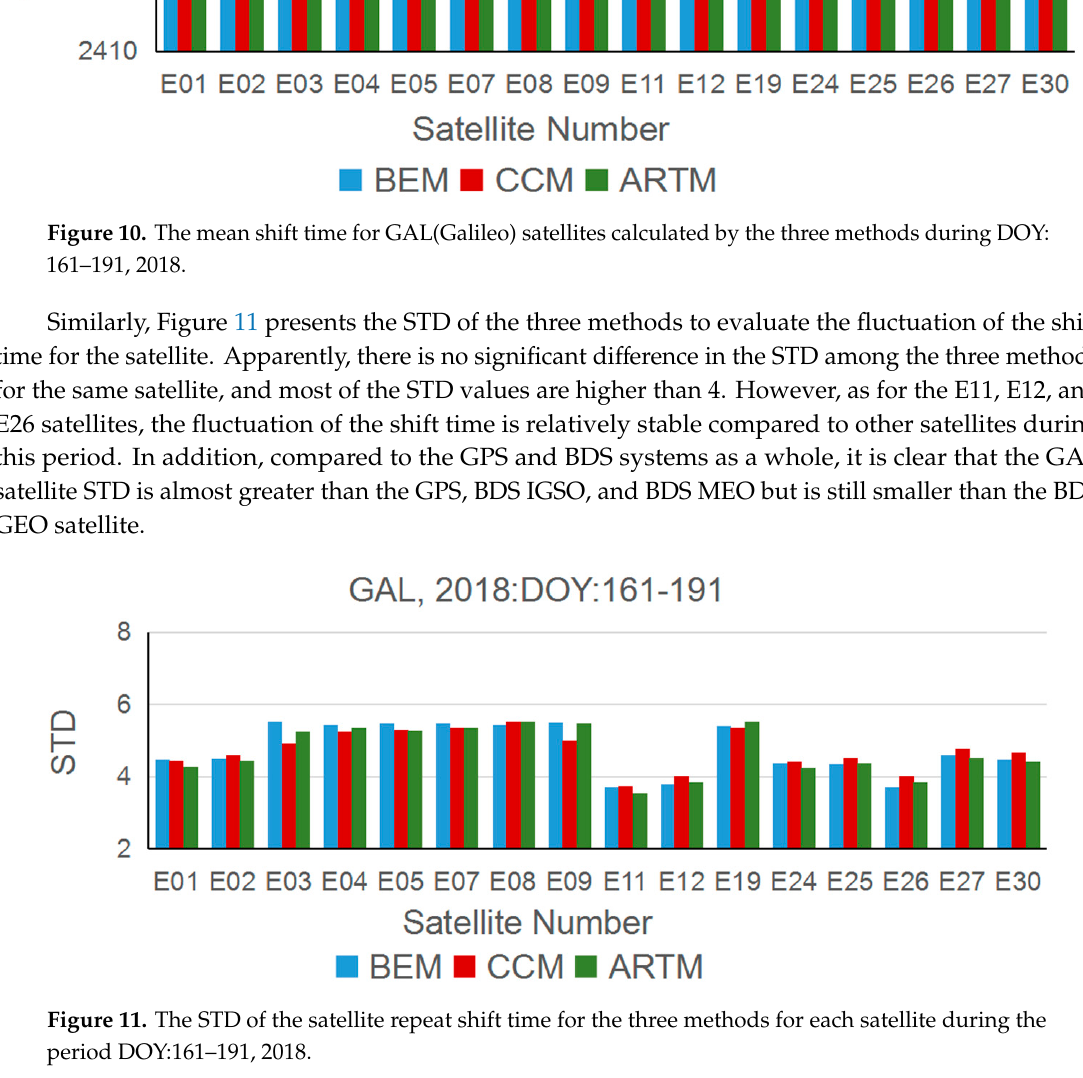
Figure 11. The STD of the satellite repeat shift time for the three methods for each satellite during the period DOY:161–191, 2018.